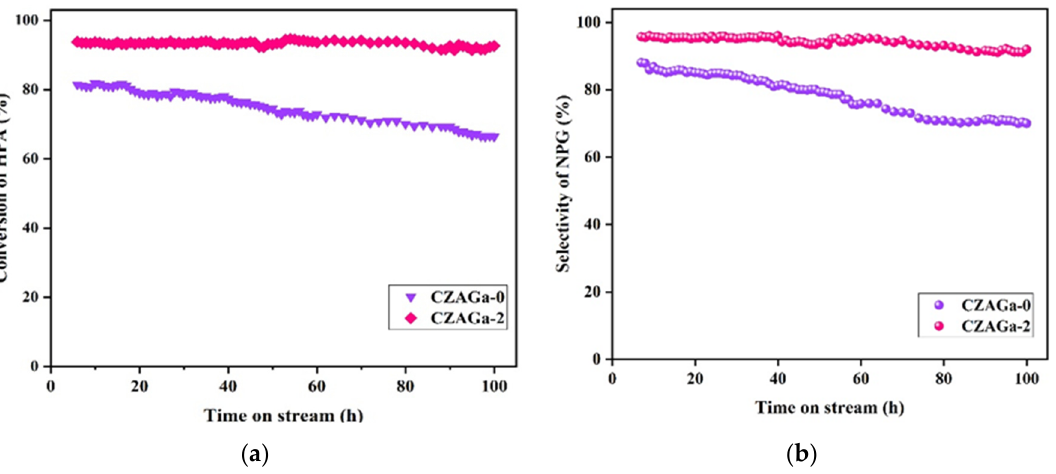
Figure 1. Catalytic performance of CZAGa-0 and CZAGa-2 as a function of reaction time. ( a ) HPA conversion with time on stream; ( b ) NPG selectivity with time on stream The reaction conditions are the same as in Table 1.